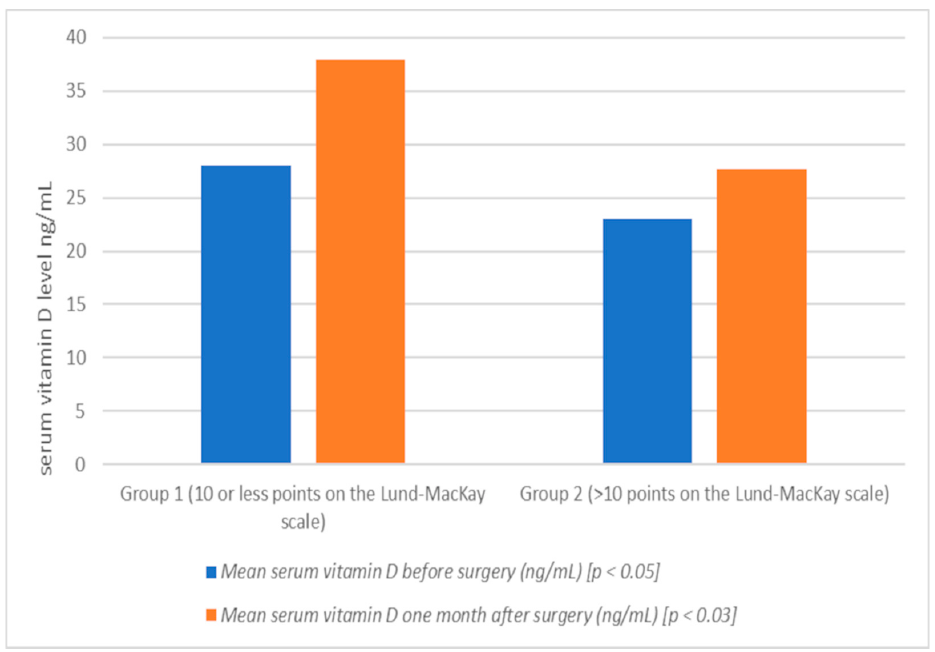
Figure 1. Mean serum vitamin D before and one month after surgery (ng/mL) in group 1 and 2 (graph).